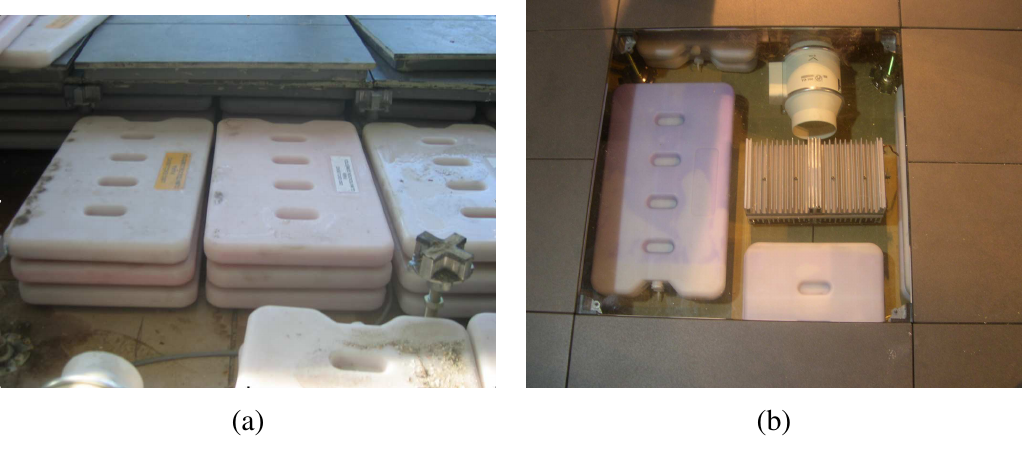
Figure 2. The false floor elements in the house.